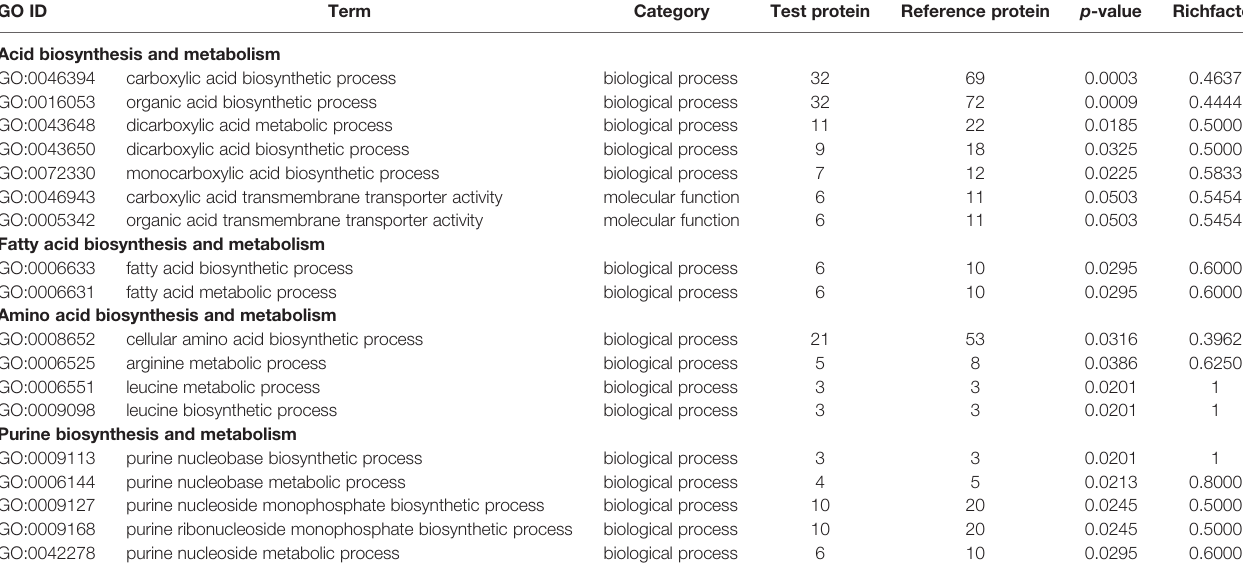
TABLE 3 | Gene ontology (GO) enrichment on ontologies for biological process, molecular function, and cellular component. GO ID Term Category Test protein Reference protein p -value Richfactor